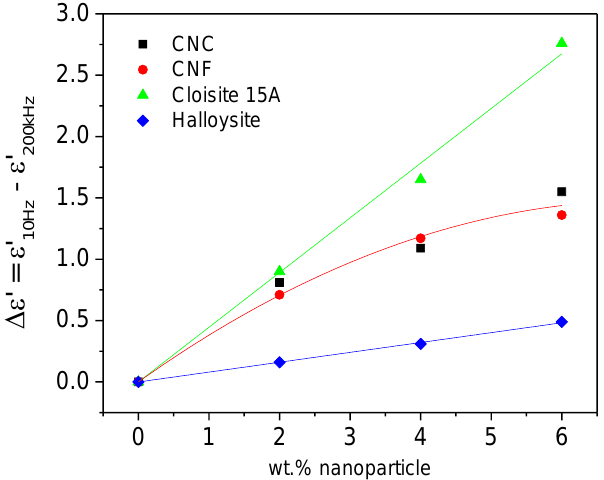
Figure 3. Evolution of the dielectric constant (permittivity) drop, ∆ ε´ = ε´ 10Hz – ε´ 200kHz , with nanoparticle concentration at 25 °C.